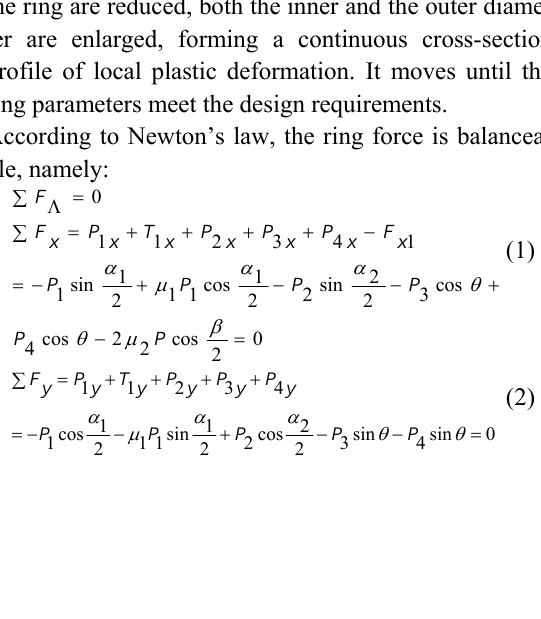
Fig. 2. The stress analysis diagram of the